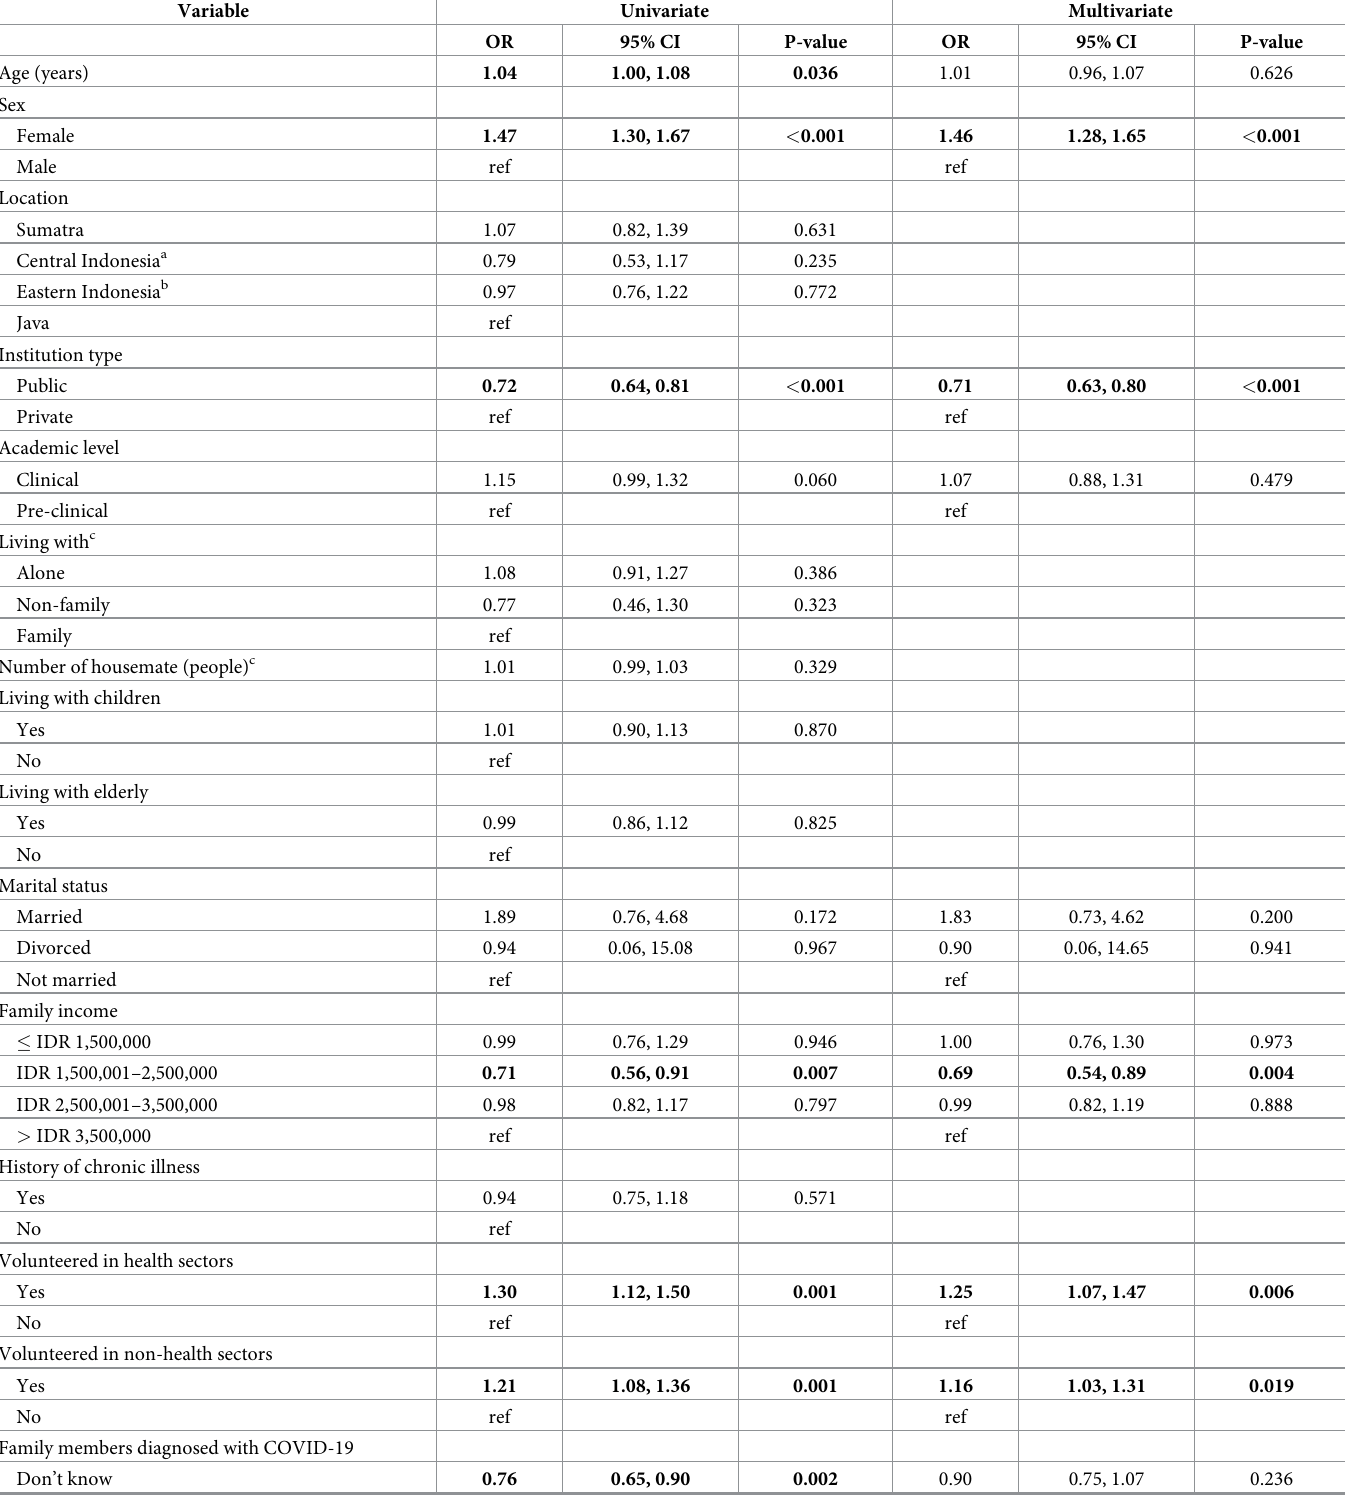
Table 3. Factors associated with practice toward COVID-19 in the study population (n =